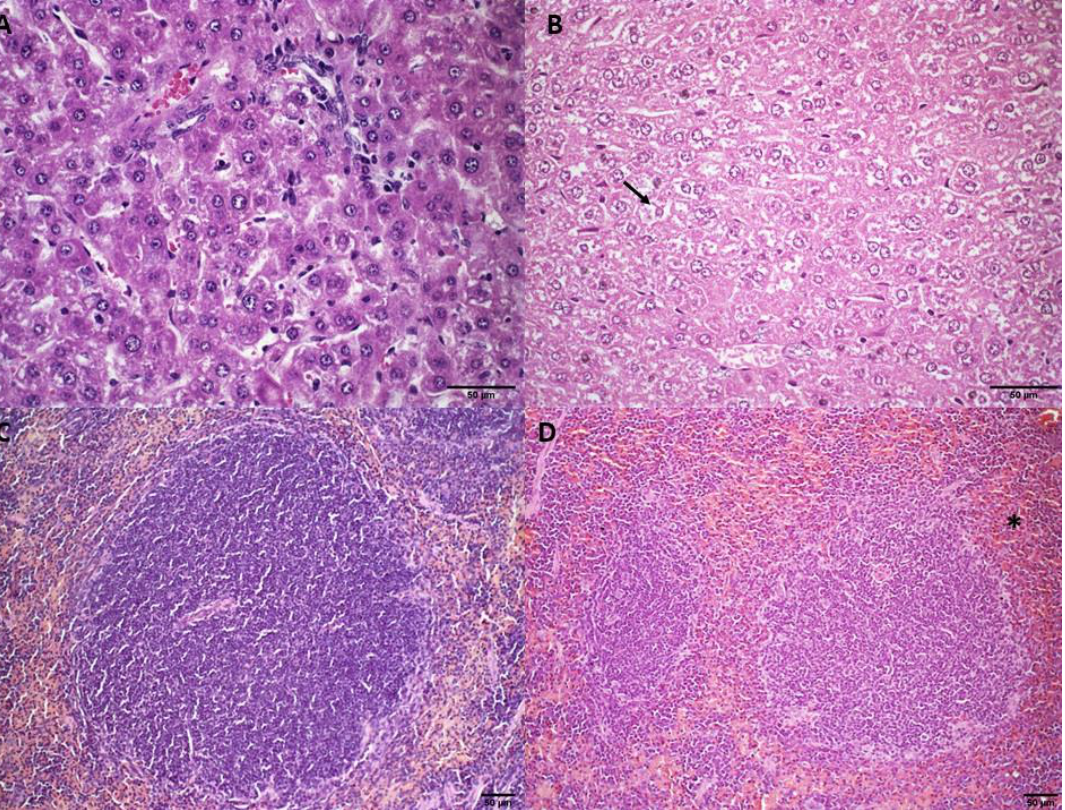
Figure 1. Histological sections of female Balb/c mice liver ( A , B ) and spleen ( C , D ). ( A ) Represents the control group (HBS) and the groups treated with SpHL-DOX and ExoSpHL-DOX at a dose of 15 mg/kg. ( B ) Represents the groups treated with both doses of free DOX (10 and 12.5 mg/kg) and the groups treated with SpHL-DOX and ExoSpHL-DOX at a dose of 17.5 mg/kg. The arrow indicates the regions of diffuse hydropic degeneration. ( C ) Represents the control group (HBS) and the groups treated with both tested doses of SpHL-DOX and ExoSpHL-DOX (15 and 17.5 mg/kg). ( D ) Represents the groups treated with both tested doses of free DOX (10 and 12.5 mg/kg). The asterisk indicates the increase in erythrocytes in the red pulp. HE, scale bar = 50 µ m.